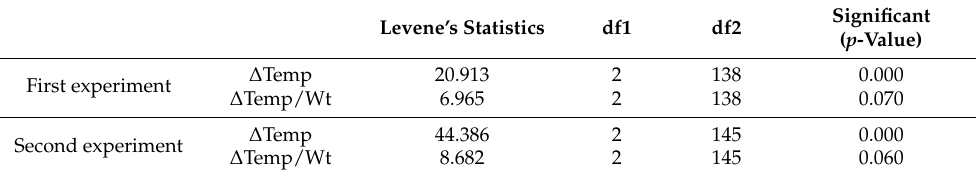
Table 6. Homogeneity test (Levene’s test) results for ∆Temp and ∆Temp/Wt data.